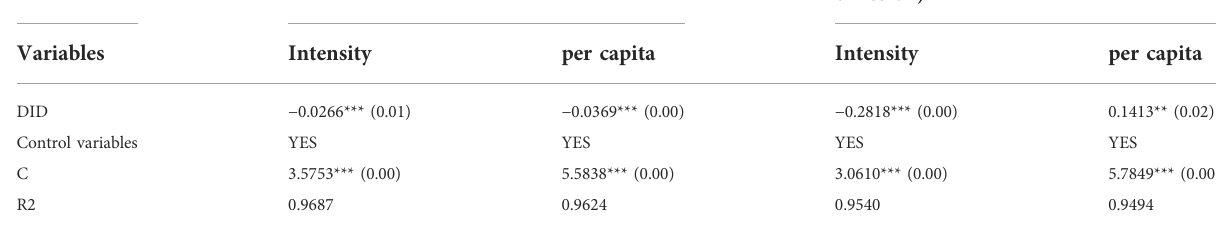
TABLE 5 Endogenous problem processing